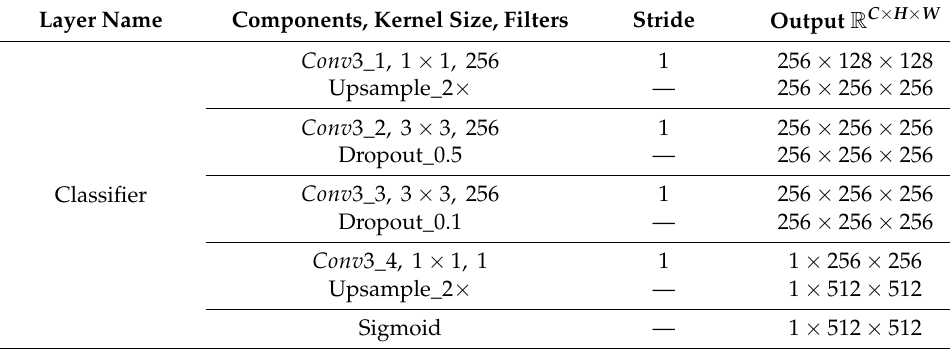
Table 2. The detailed architecture of the 3M-CDNet classifier.